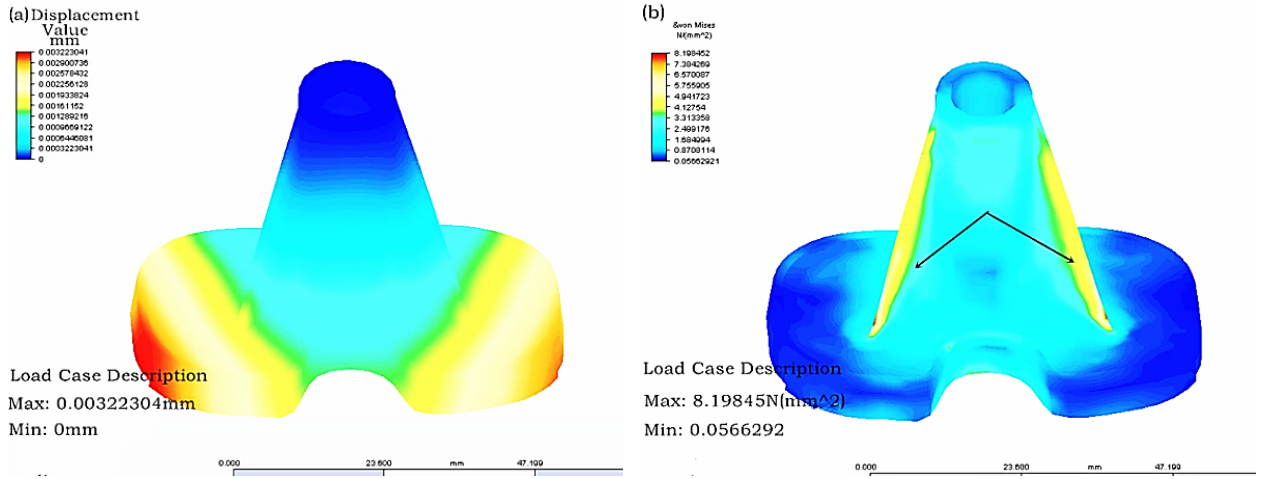
Figure 5. Results of finite element analysis of a tibial implant: ( a ) Displacement distribution; and ( b ) Stress distribution.